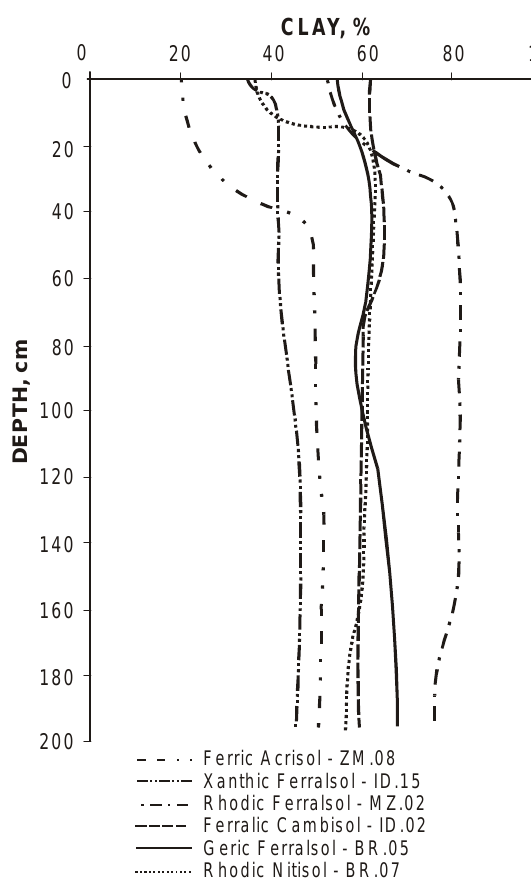
Figure 2. Clay distribution in profiles of representative upland soil of humid and subhumid tropical